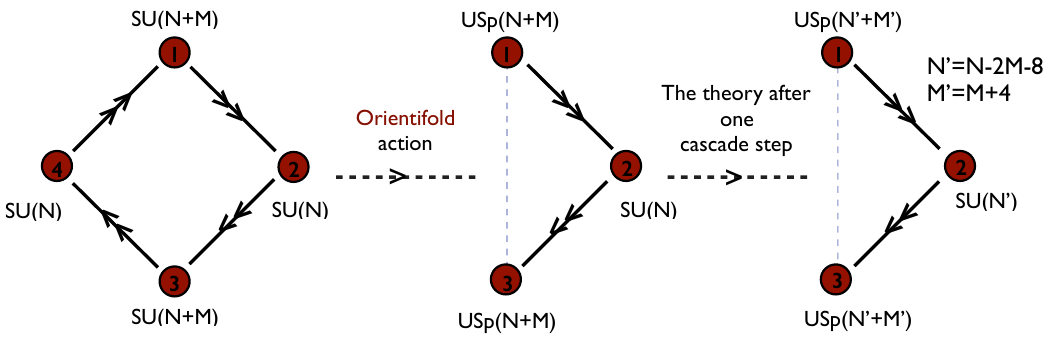
Figure 2 . F 0 = (cid:10) theory with fractional branes. On the left, the parent theory. On the extreme right, the orientifold theory after one cascade